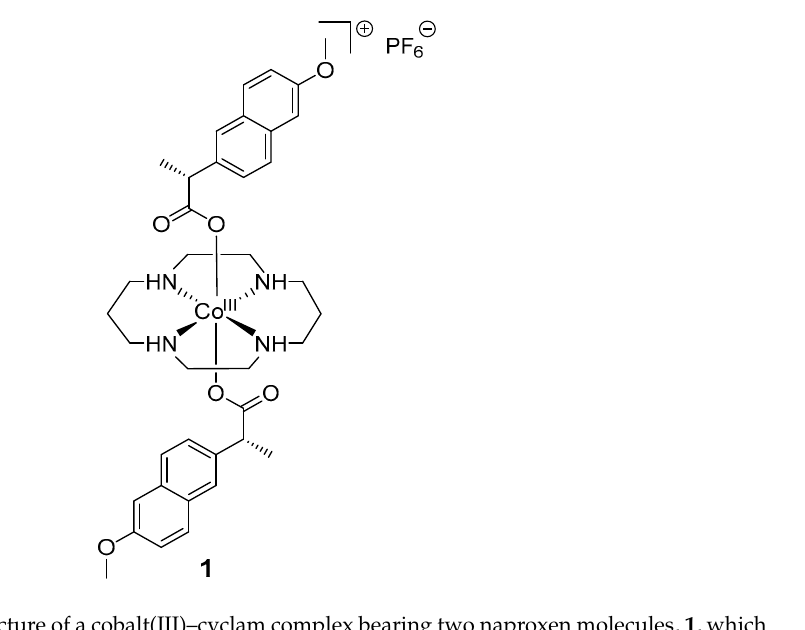
Figure 1. Chemical structure of a cobalt(III)–cyclam complex bearing two naproxen molecules, 1 , which was previously reported to selectively kill breast cancer stem cells (CSCs) over bulk breast cancer cells.